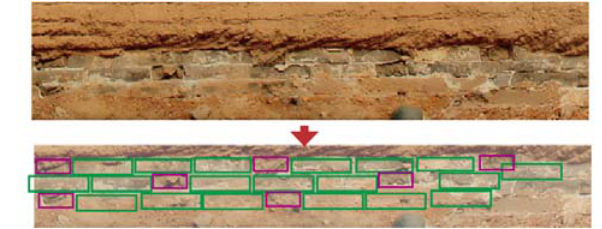
Figure 6. The stretch map for construction with